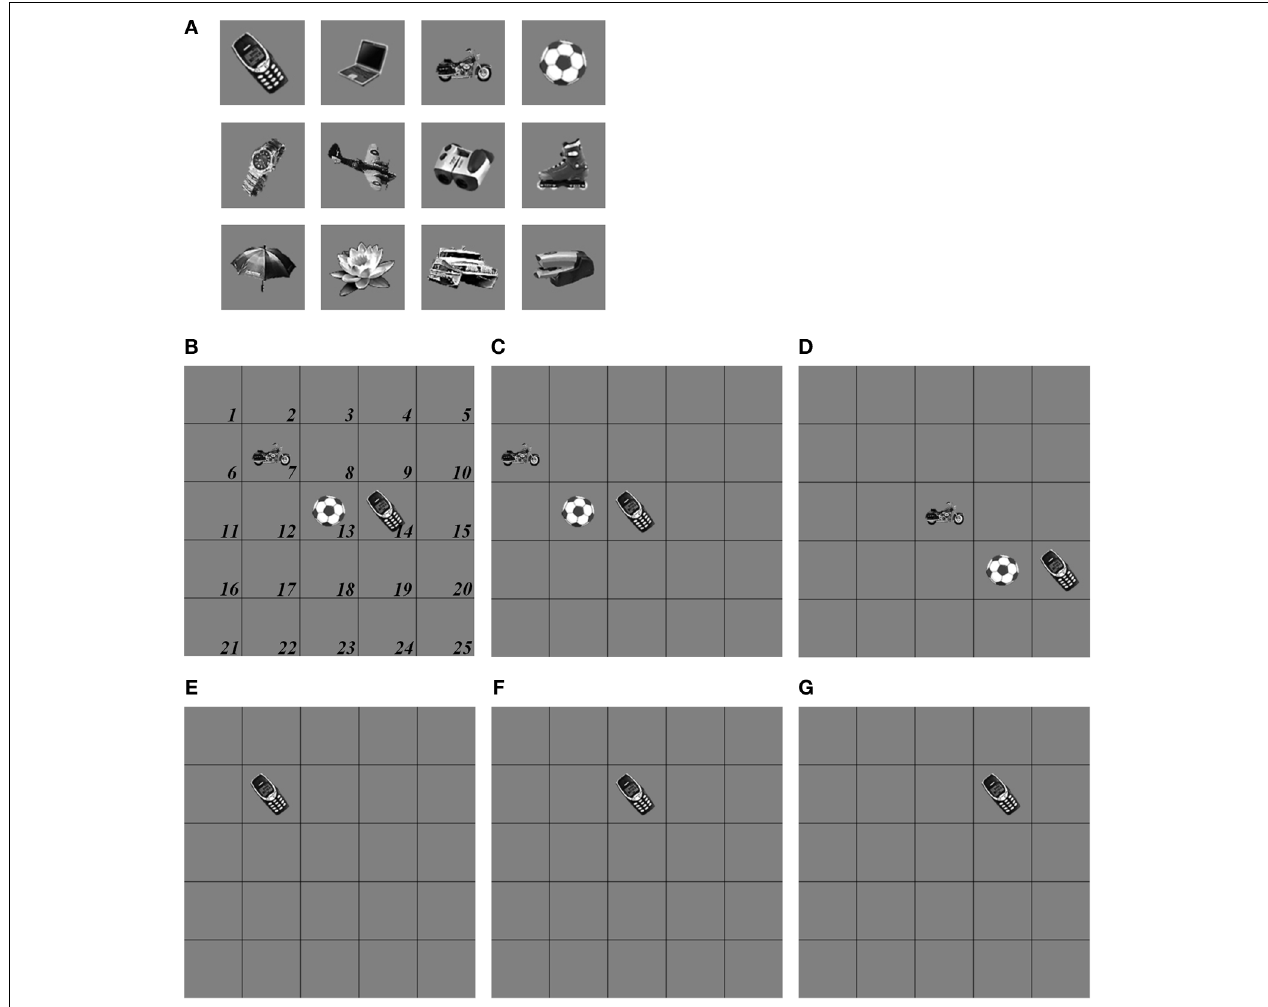
FIGURE 8 | Set of object stimuli for view- and positionally-invariant category learning. (A) Each object reflects the relative size within 100 × 100 pixels from Caltech 101 dataset. (B) A simulated scene for simulations of view-invariant object category learning in section 8.1. A scenic input image is partitioned into 25 regions (solid lines) and objects are located in the central regions of the input scene (regions 7, 8, 9, 12, 13, 14, 17, 18, and 19). Region 5 is the foveal region and others are the